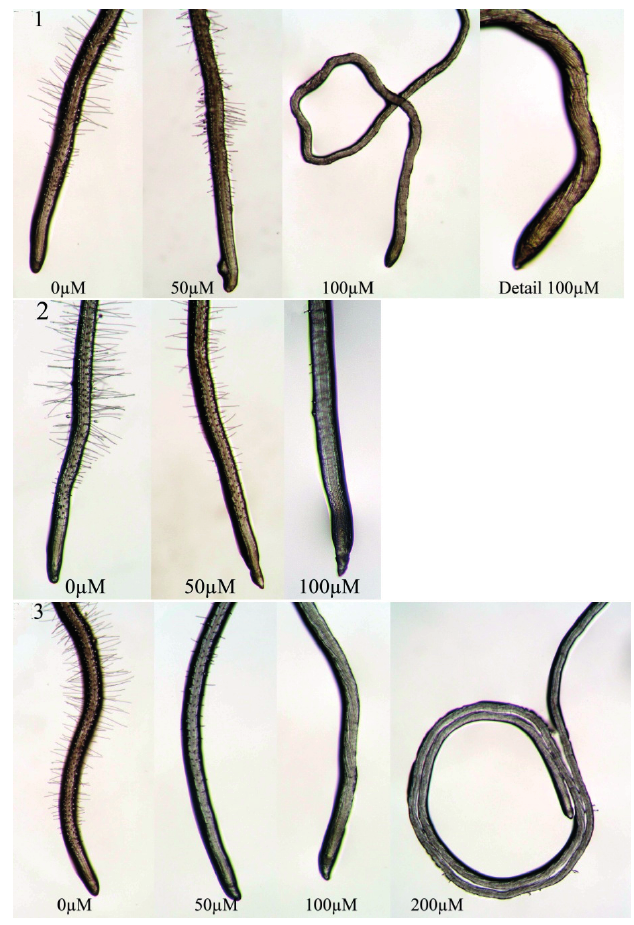
Figure 5. Root apex of A. thaliana grown in vitro and treated with different concentrations of 1 – 3 . The anticlockwise torsion of the cell files and the absence of root hairs (when treated with molecules 1 and 3 ) are